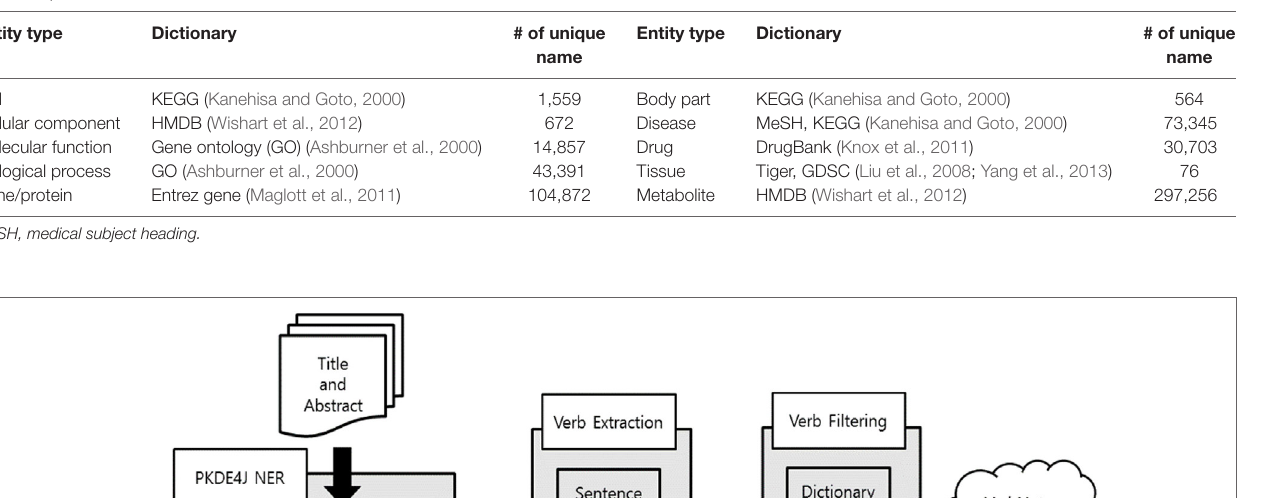
TaBle 2 | Dictionaries used to construct biomedical verbs.